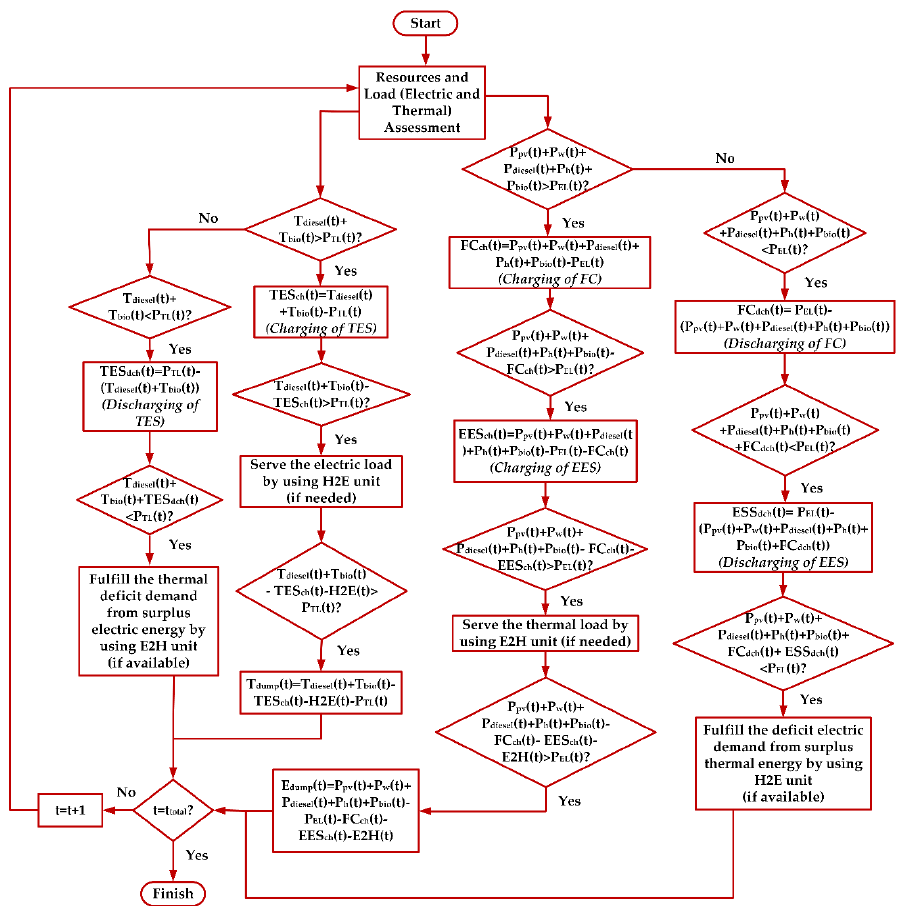
Figure 1. System architecture of a diesel-based MEG.